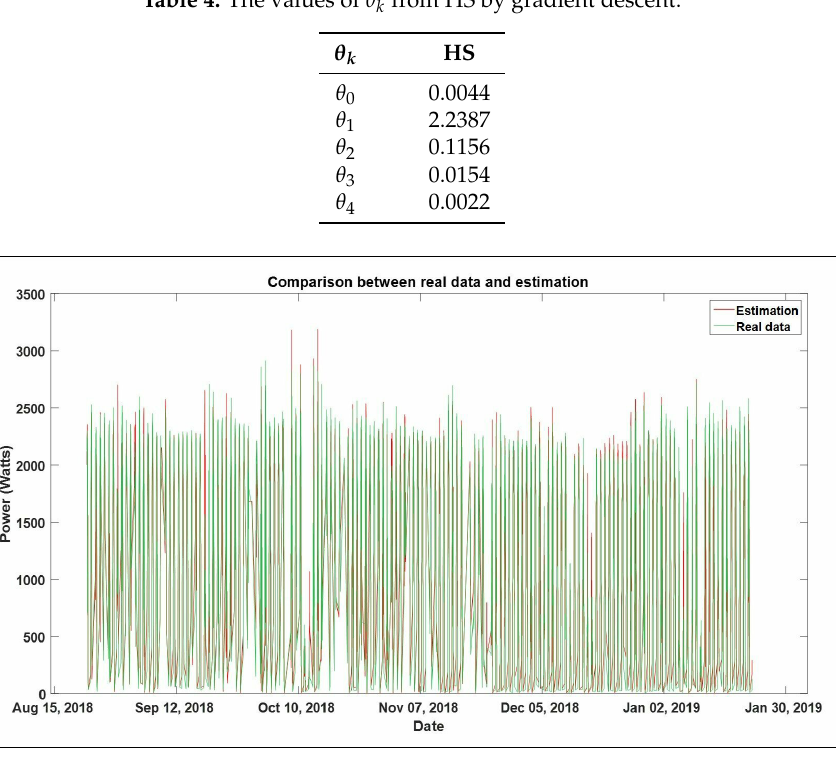
Table 4. The values of θ k from HS by gradient descent.